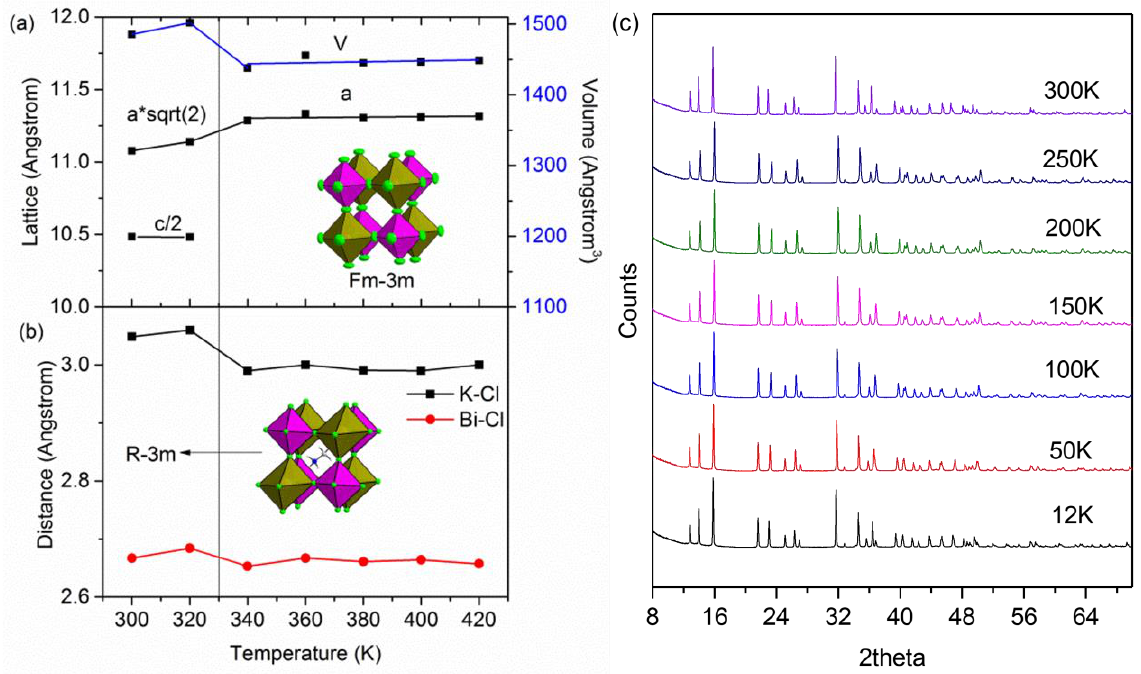
Figure 1. ( a ) Lattice parameters variations as a function of temperature. The lattice parameters of the rhombohedral cell were converted into its equivalent cubic setting. ( b ) Bond distance variations. Octahedral arrangements at both rhombohedral and cubic symmetry are illustrated (MA cation is omitted in cubic cell for illustration purpose. Green: Cl, purple BiCl 6 , brown: KCl 6 . ( c ) The VT synchrotron PXRD patterns.